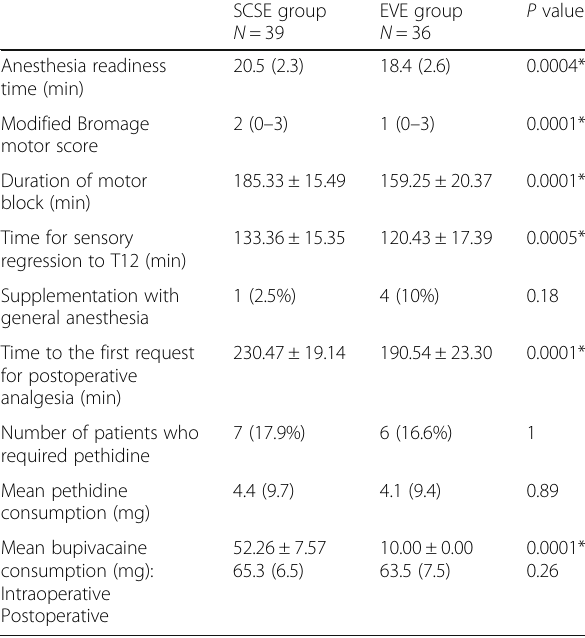
Table 1 Demographic characteristics of the patients